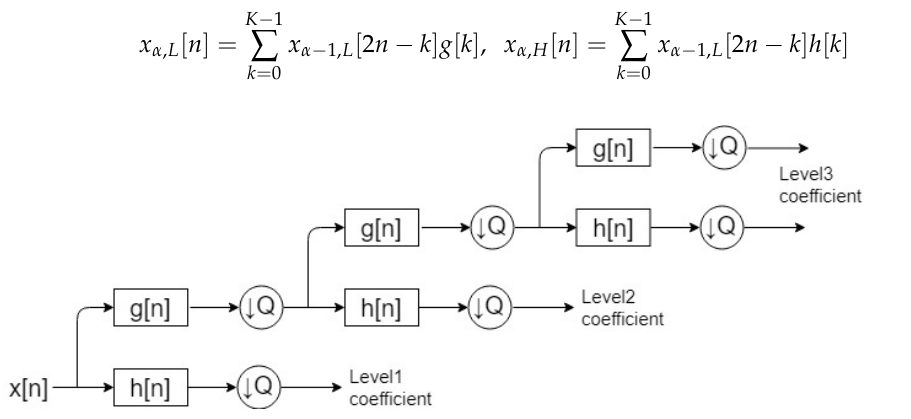
Figure 7. Discrete WT .